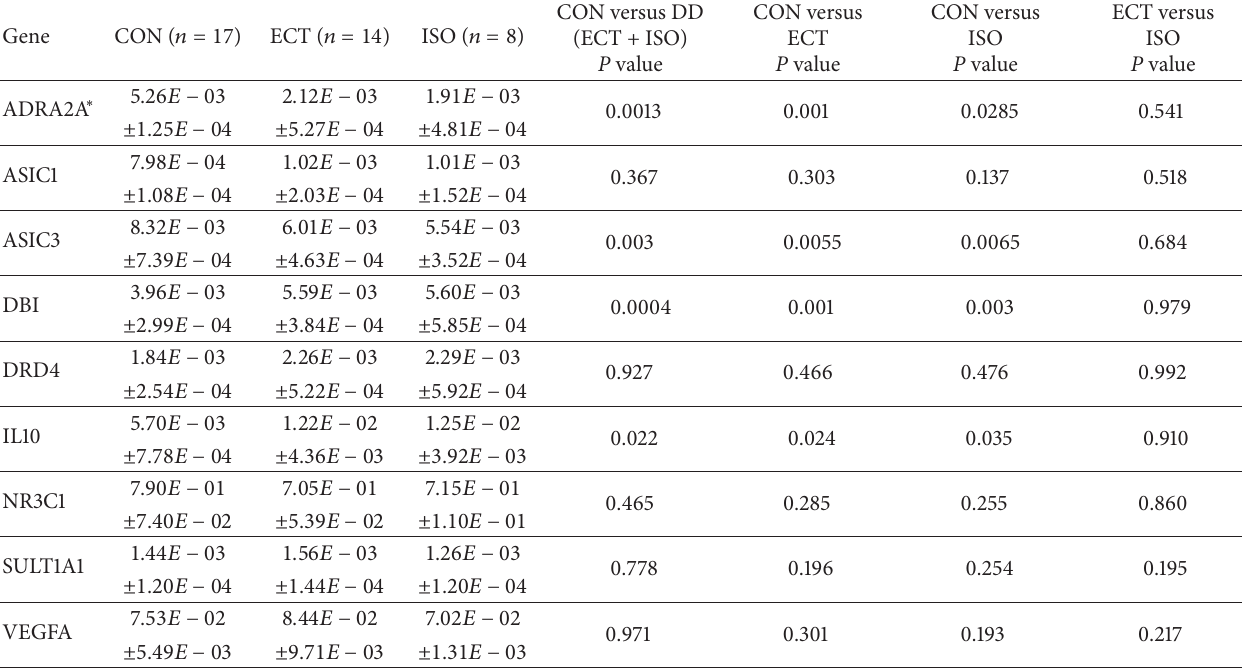
Table 2: Pretreatment gene expression in controls (CON), ECT, and ISO Groups.